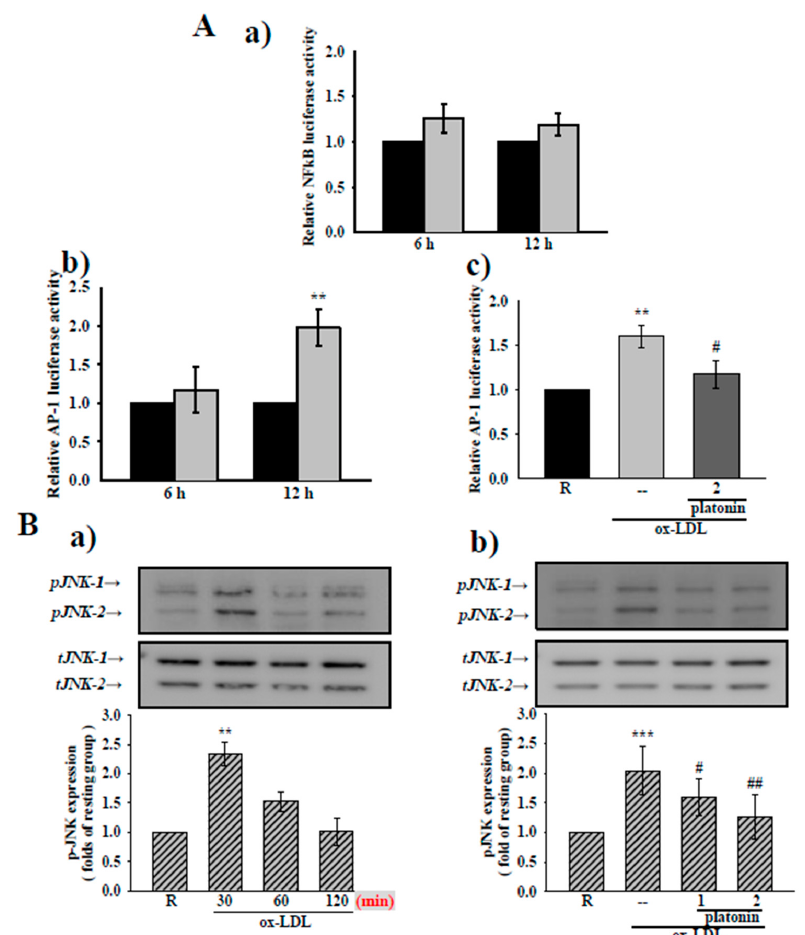
Figure 4. Effects of platonin on AP-1 activity and JNK phosphorylation in ox-LDL-stimulated vascular smooth muscle cells (VSMCs). ( A ( a )) VSMCs were transiently transfected with NF- κ B-luc and Renilla-luc plasmids for 24 h and then treated with ox-LDL (20 µ g/mL) for 6 h or 12 h. ( A ( b , c )) Transient transfection with AP-1-luc and Renilla-luc plasmids were also performed in VSMCs for 24 h. After transfection, the cells were pretreated without ( b ) or with ( c ) platonin (2 µ M) for 30 min then treated with the ox-LDL (20 µ g/mL) for 6 h or 12 h (black bar: resting group; gray bar: ox-LDL-treated group; deep-gray bar: platonin+ ox-LDL-treated group). A luciferase assay was performed as described in “Materials and Methods.” ( B ) Cells were pretreated without ( a ) or with platonin (1 or 2 µ M) ( b ) for 30 min, then treated with ox-LDL (20 µ g/mL) for ( a ) the indicated time or ( b ) 30 min. The extent of JNK phosphorylation was then determined through Western blotting assay. Data are represented as mean ± S.E.M. ( n = 3); ** p < 0.01, *** p < 0.001 compared with the resting (R) group; # p < 0.05, ## p < 0.01 compared with the positive control